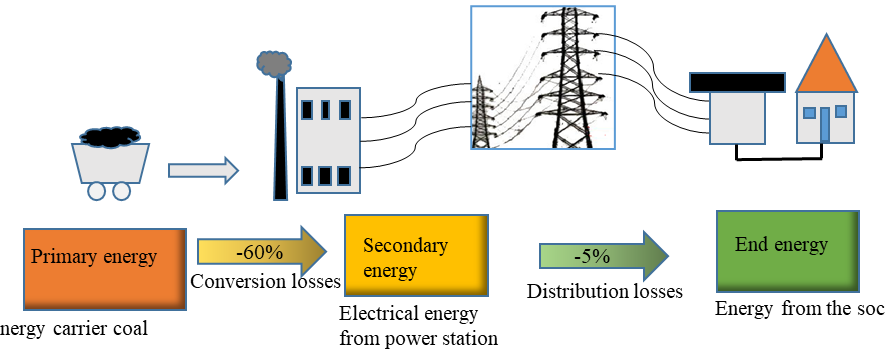
Figure 8. Description of energy transportation from fossil fuel to the consumer.